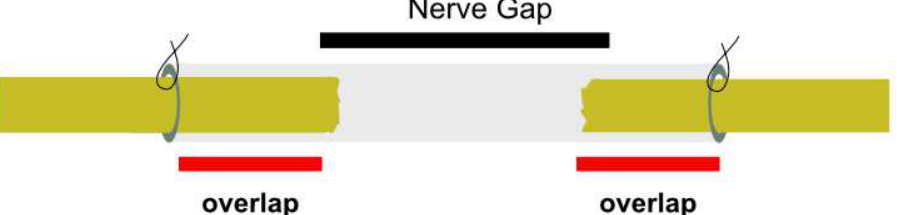
Figure 1. Analysis of the lesion side after finger trauma. Patient with a peripheral nerve defect of the ulnar nerve of the little finger ( A ) and bridging by a CNC. In this case, a peripheral nerve defect of approximately 9 mm is bridged by the CNC (Magnification A 2×). Schematic illustration of the tubulization technique for bridging the peripheral nerve defect with the CNC. Note the 2–3 mm overlap of CNC proximal and distal to allow guided sprouting of the axons via the conduit ( B